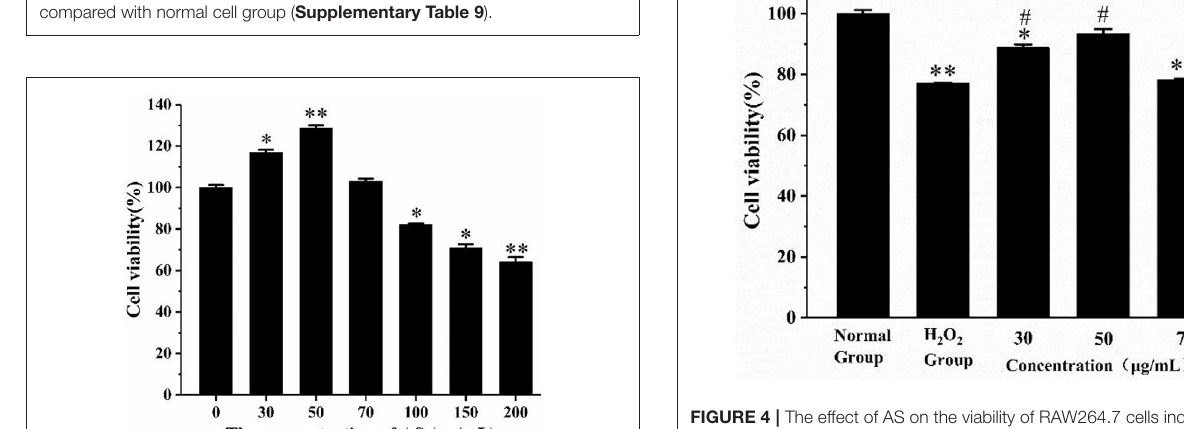
FIGURE 4 | The effect of AS on the viability of RAW264.7 cells induced by H 2 O 2 . Cells were treated with different concentrations of AS for 20h. The positive control group and AS-treated groups were then exposed to H 2 O 2 (400 µ M) for 4h. The results were presented as the mean ± SE of three independent experiments. * P < 0.05 compared with the normal cell group, ** P < 0.01 compared with the normal cell group. # P < 0.05 compared with H 2 O 2 , ANOVA analyses ( Supplementary Table 7